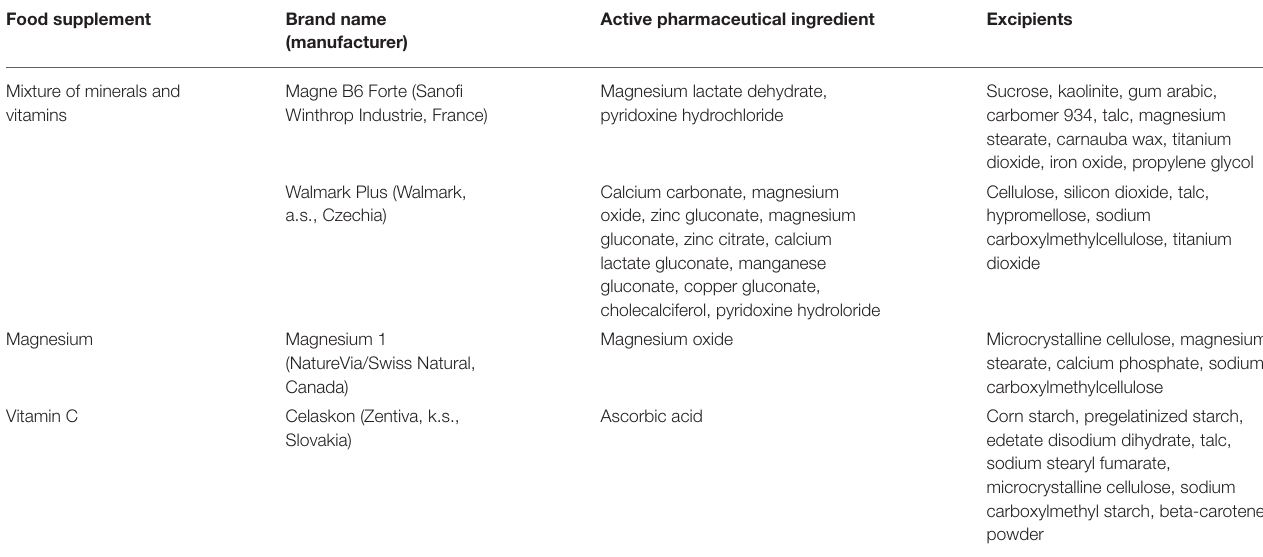
TABLE 2 | List of the used food supplements and their composition. The data were taken from the patient information leaflets or packaging. Food